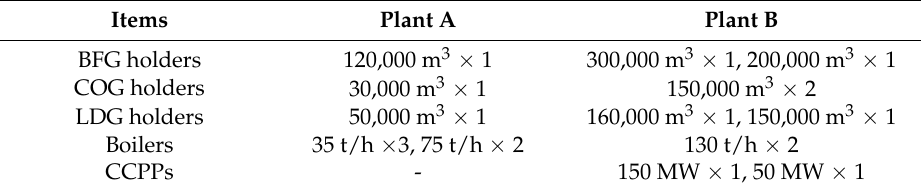
Table 1. The configurations for gasholders, boilers, and combined cycle power plants (CCPPs) in Plant A and Plant